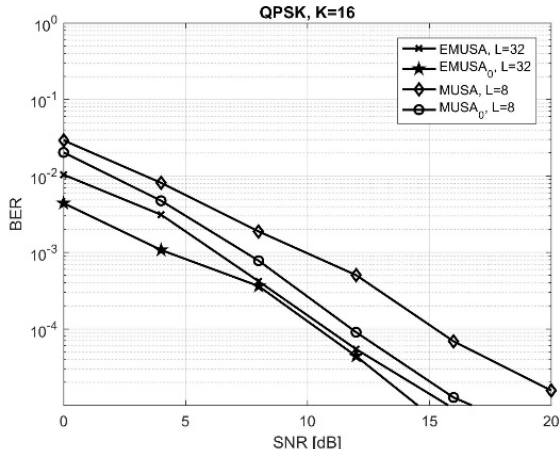
Figure 5. BER vs. SNR for a (1 × 30 × 30) MIMO configuration, QPSK modulation, MUSA and EMUSA complex spreading codes with 16 active users.